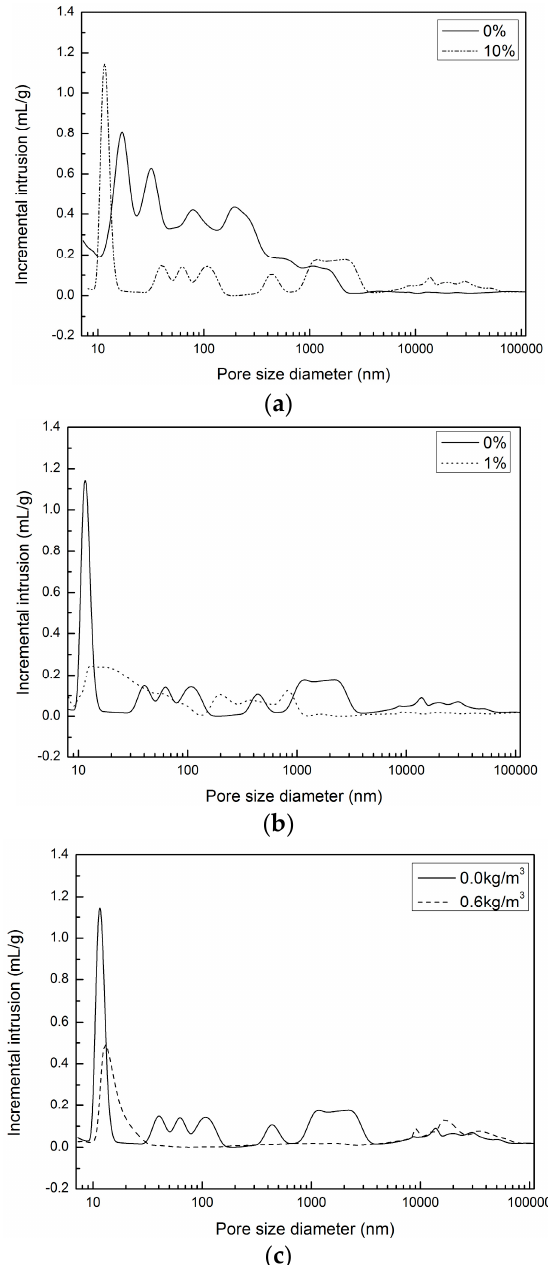
Figure 11. Pore size distribution results of concrete with different contents of: ( a ) AMF; ( b ) aluminum sulfate; ( c ) PPF.